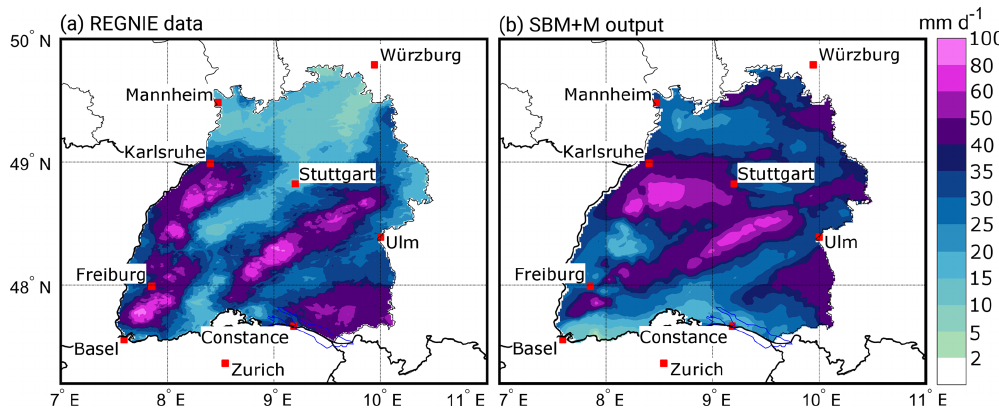
Figure 8. Comparison of (a) REGNIE 24h rainfall totals, and (b) SBM + M output for southwestern Germany for the case study on 31 May 2013. Note that REGNIE data are available for Germany only. The parameterization in (b) is τ x = 1400s, f C and c oro = 0 . 8. The areas outside of Baden-Württemberg are white for better visualization and comparison.